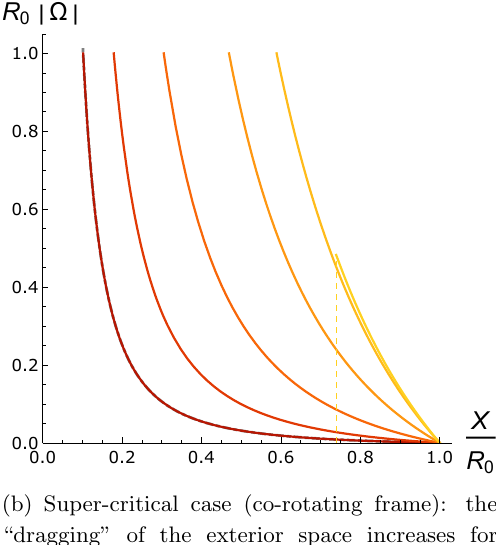
momentum of the brane (proportional to (cid:22) ! ) drags along the bulk spacetime with diminishing e(cid:11)ect as we move further away. Figure 7 . Radial pro(cid:12)le of the rotation function (cid:10)( r ) with parameter values and color coding ((cid:22) ! increasing from dark to light) as speci(cid:12)ed in (cid:12)gure 4 and (cid:12)gure 6, respectively. The dashed-dotted lines correspond to the analytic result in the slowly rotating